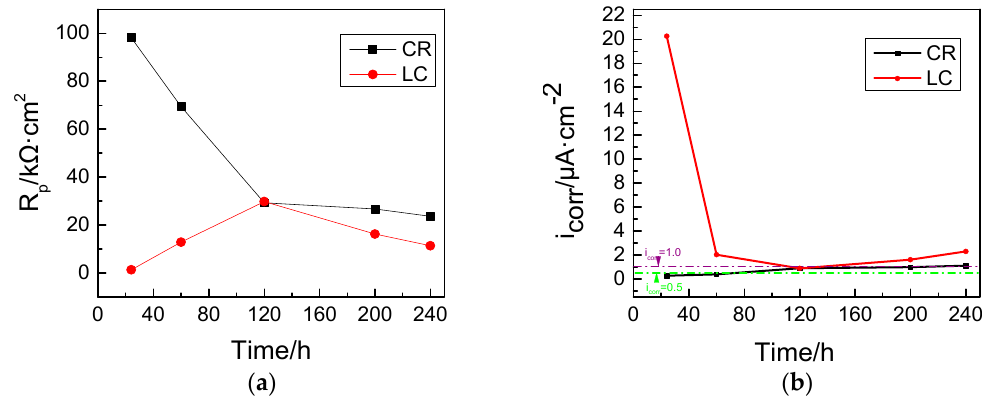
Figure 1. Linear polarisation resistance ( a ) and corrosion current density ( b ) of two types of steel bars at different corrosive exposure times.